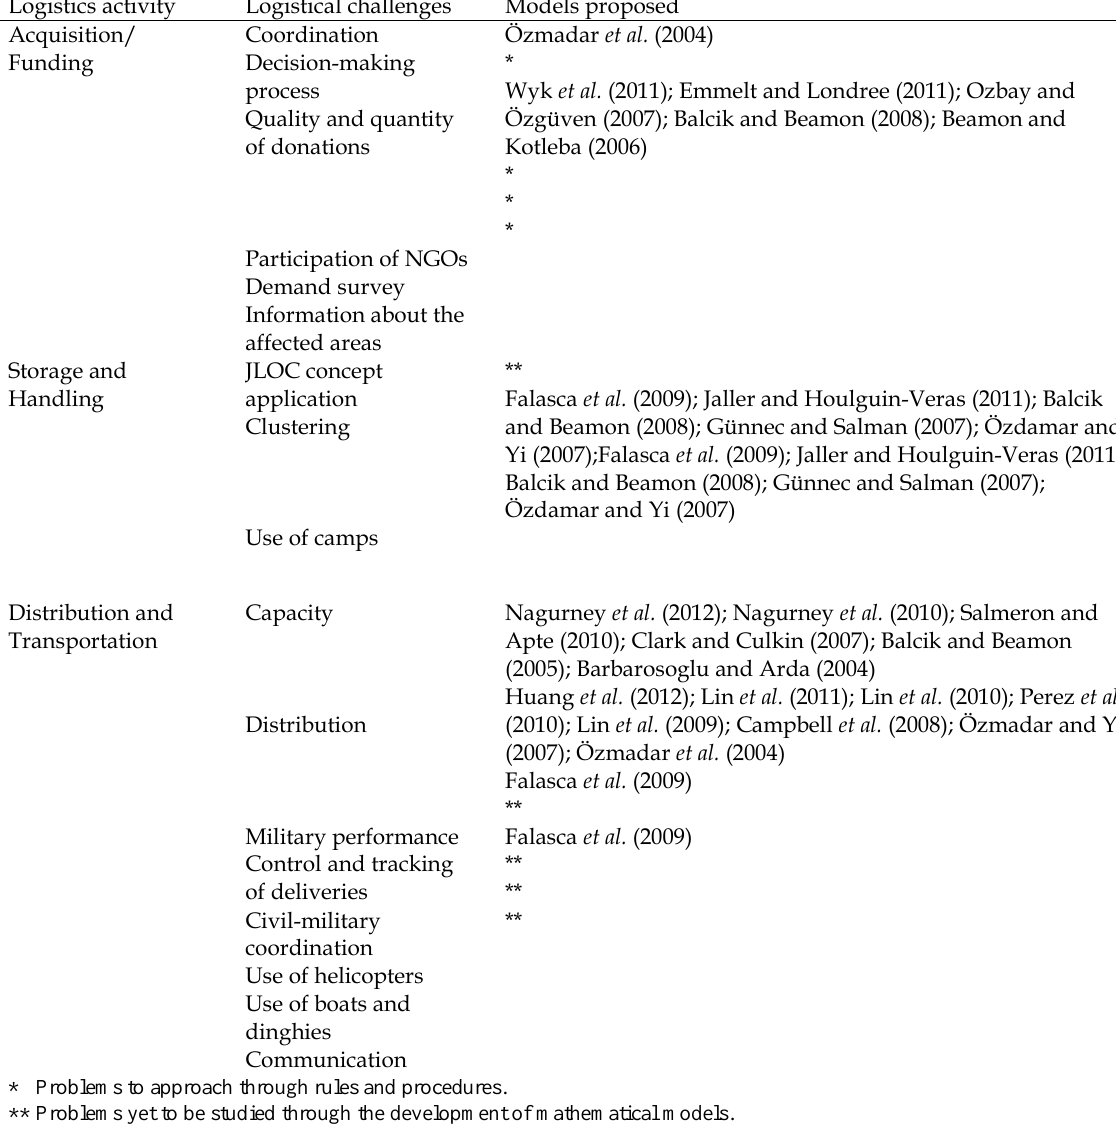
Table 4. Articles related to opportunities for improvement in humanitarian